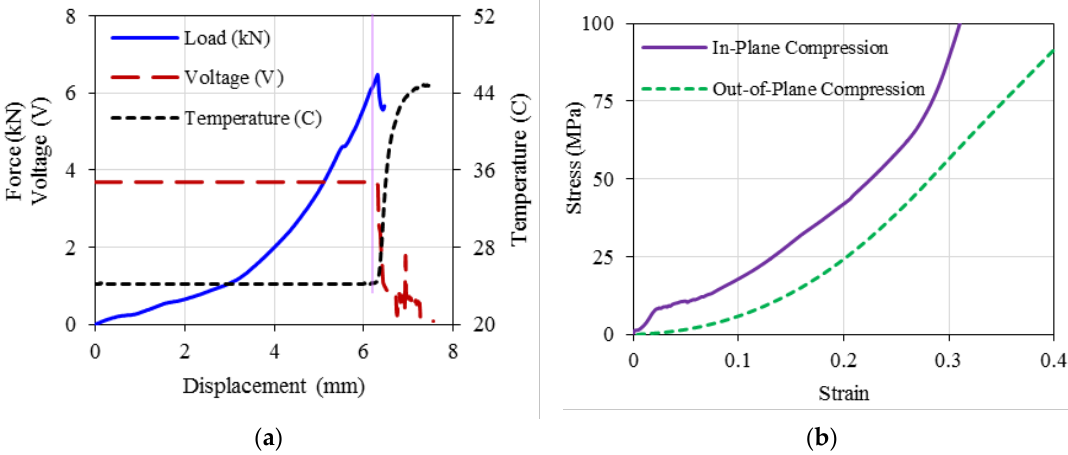
Figure 4. ( a ) Typical measurements of force, voltage, and temperature from tests on Li-ion cells, reproduced from [35]. A local peak in force, a drop in voltage, and a rise in temperature indicates a short circuit in the cell; ( b ) Typical stress-strain curves from in-plane and out-of-plane compression tests on Li-ion battery cells [9].